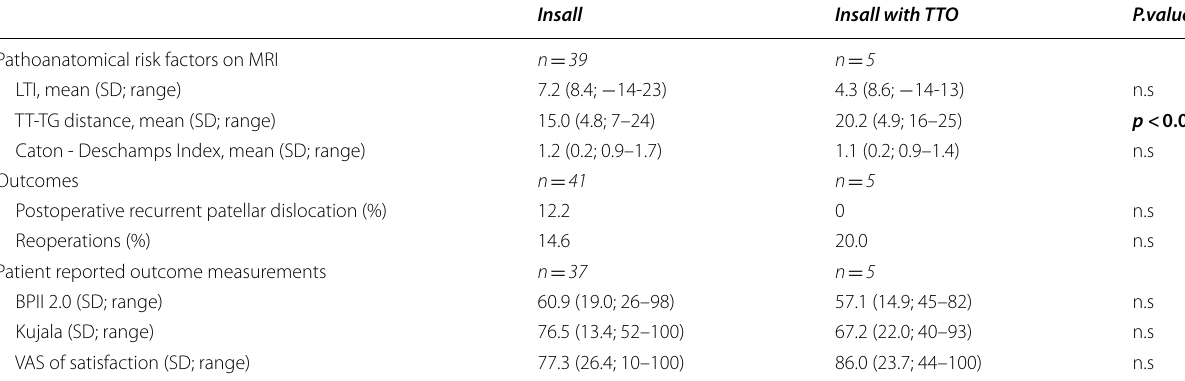
Table 2 Between‑groups differences (Insall with/without TTO)